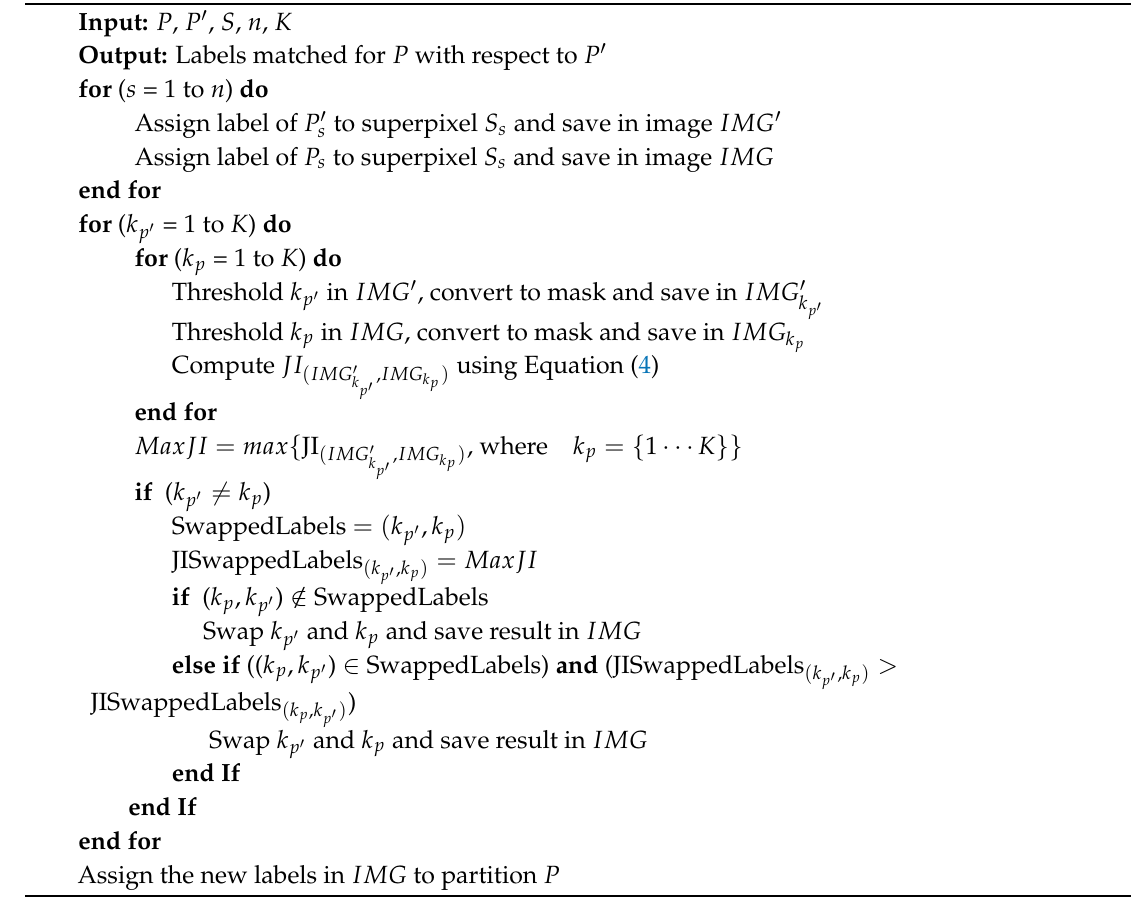
Algorithm 1: Label Matching Algorithm for the Vote-CC